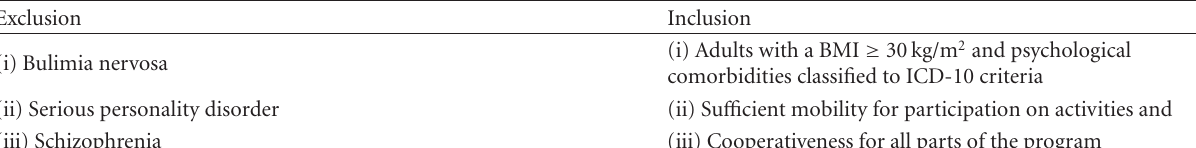
Table 1: Inclusion and exclusion criteria of the study.